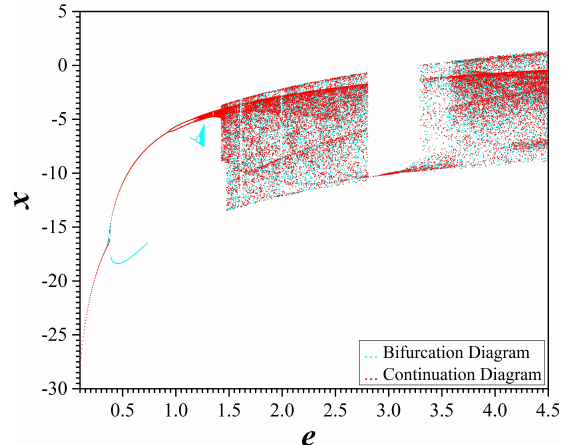
Figure 14. Bifurcation diagram (cyan) and continuation diagram (red) of system (2), when parameter e is increased, for a = 4 × 10 − 4 , b = 1, c = 3.846 × 10 − 4 and d = 1, when parameter e is increased.